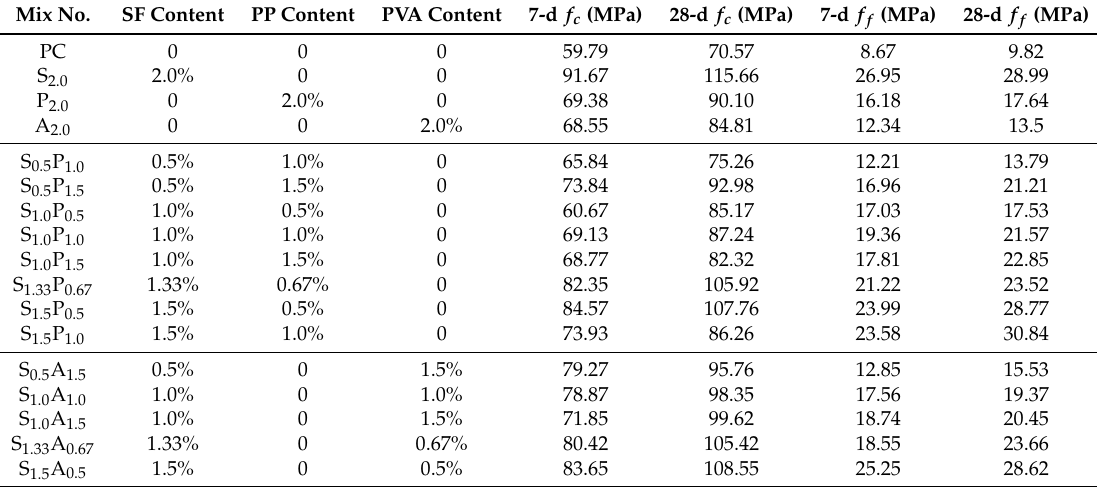
Table 3. Compressive and nominal flexural strength of